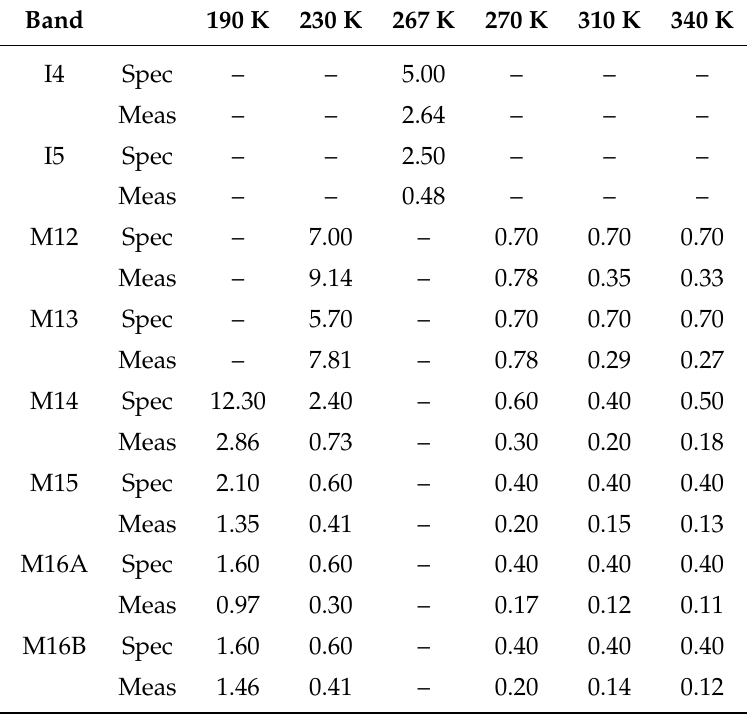
Table 5. Estimated uncertainty [% radiance] compared to the sensor specifications